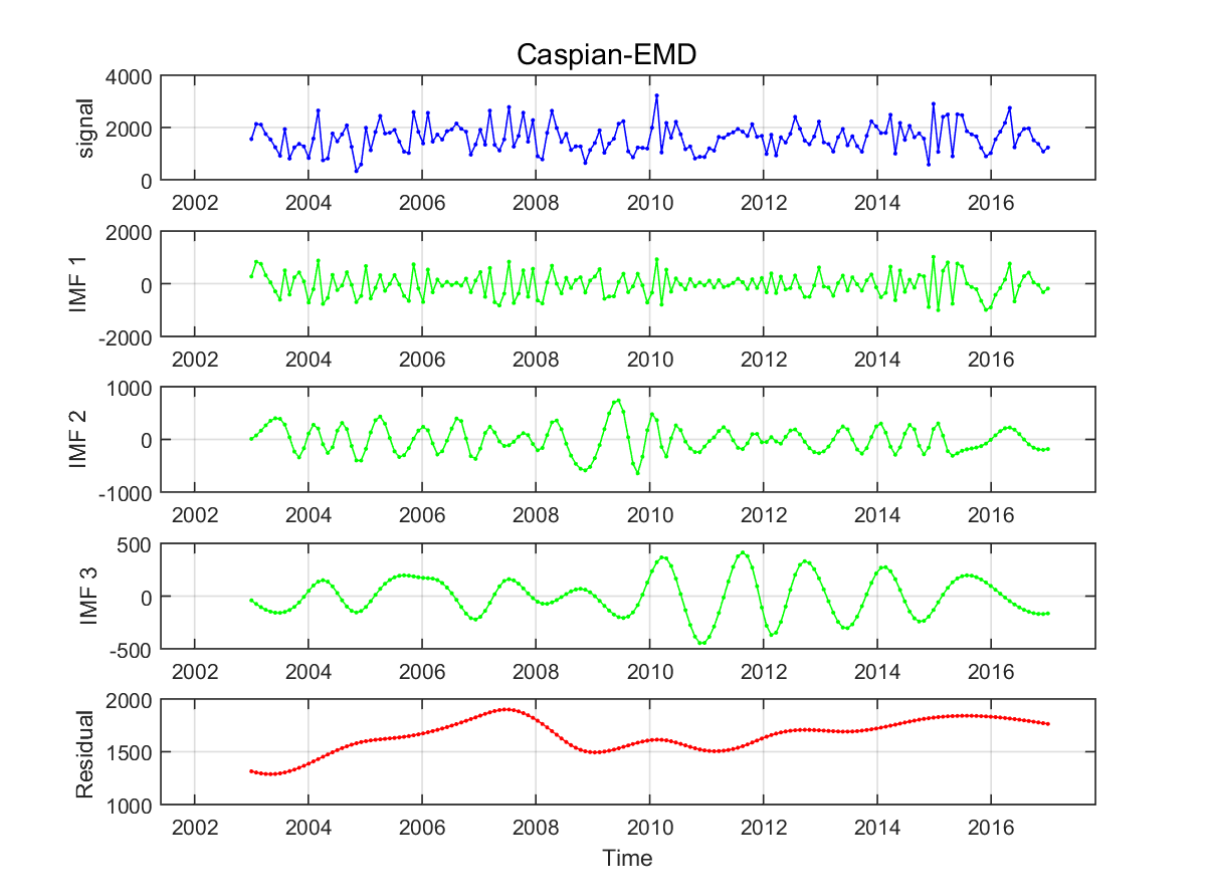
Figure 7. Top row is the original signal, middle rows are the significant IMFs and last row is summing other IMFs and residual.